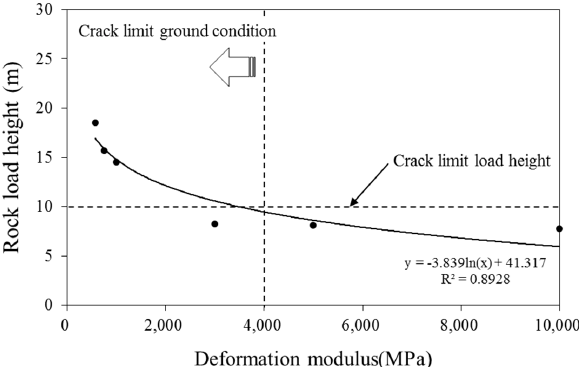
Figure 19. Rock load heights at various deformation moduli after the completion of excavation of the left tunnel.